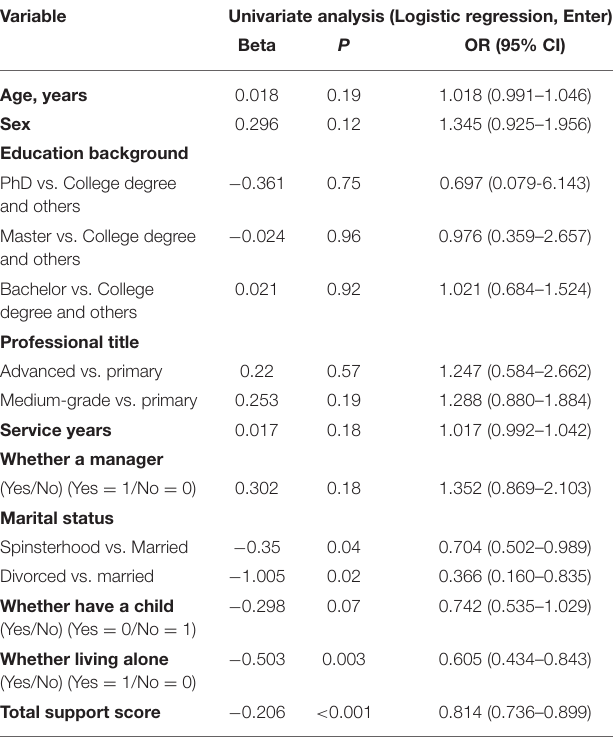
TABLE 4 | Analysis of influencing factors of that nurses are worried about the COVID-19 pandemic.